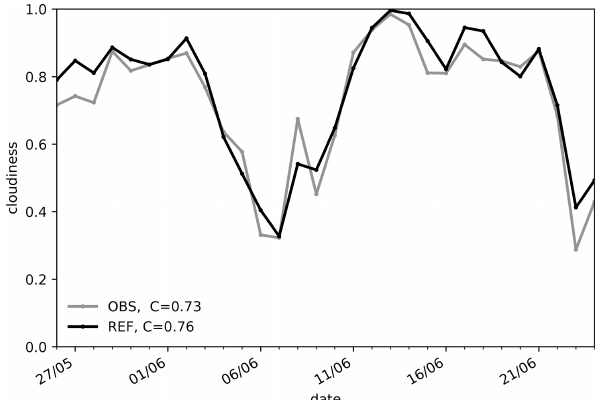
Figure 4. Time series of observed and simulated cloudiness at 12:00UTC during the period from 26 May to 24 June 2016. The cloudiness is defined as the fraction of pixels where 0.6µm SEVIRI solar reflectance R > 0 .